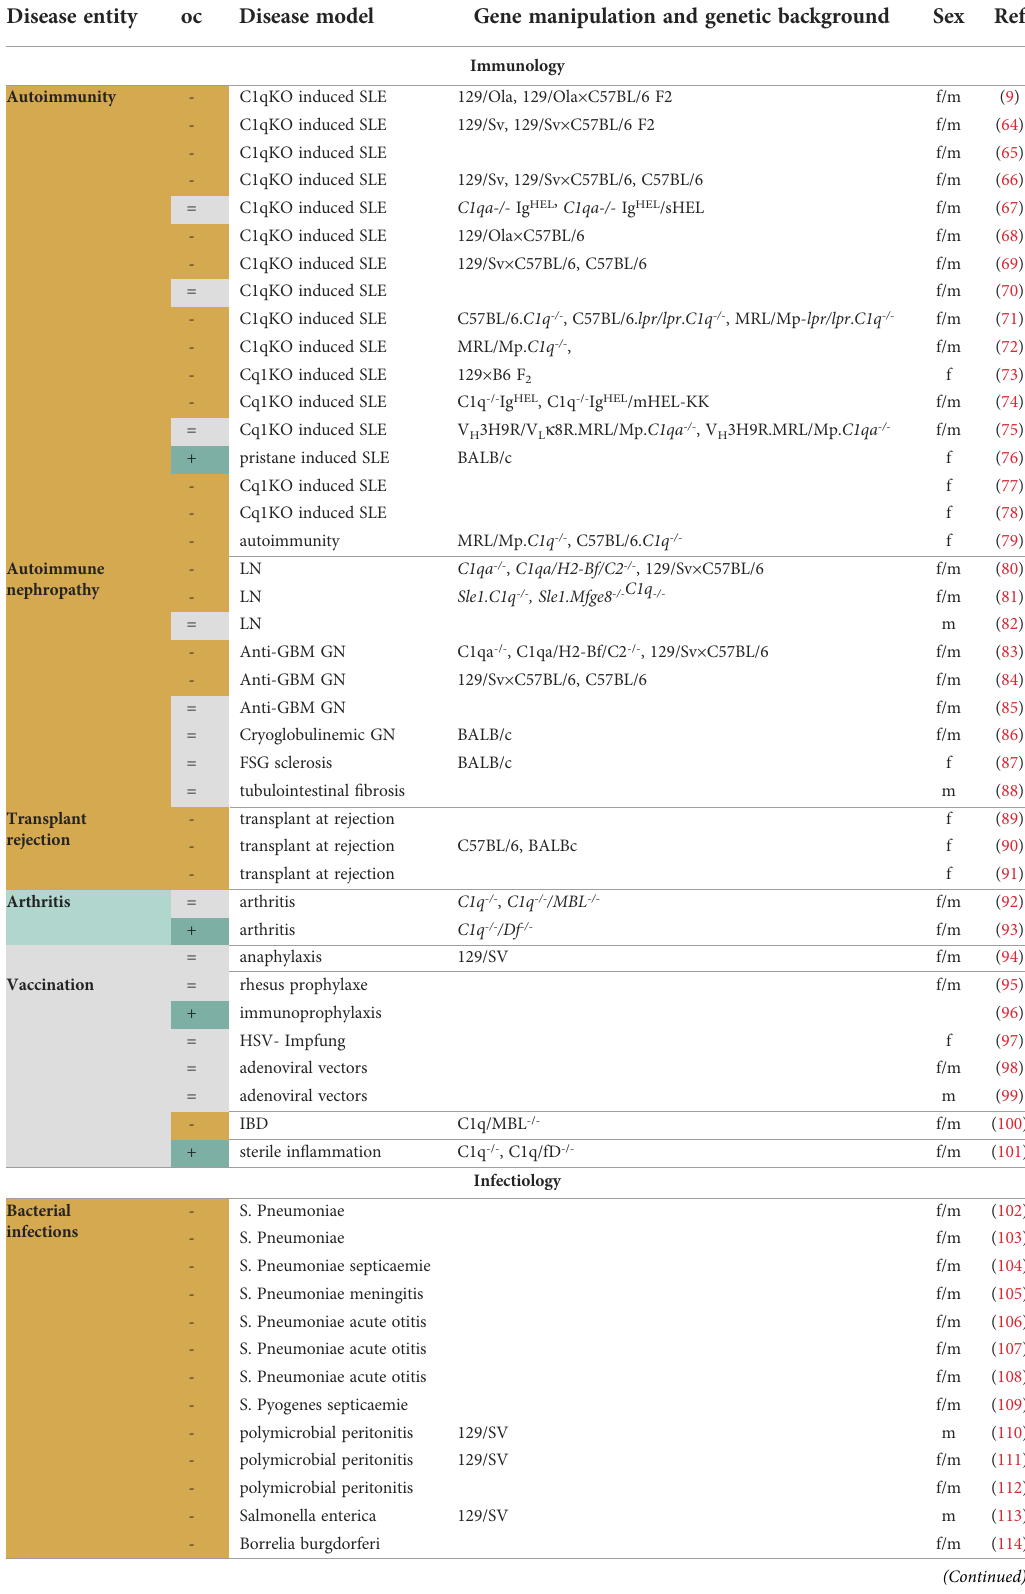
TABLE 2 Overview of publications in the disease clusters autoimmunity and infectiology. Disease